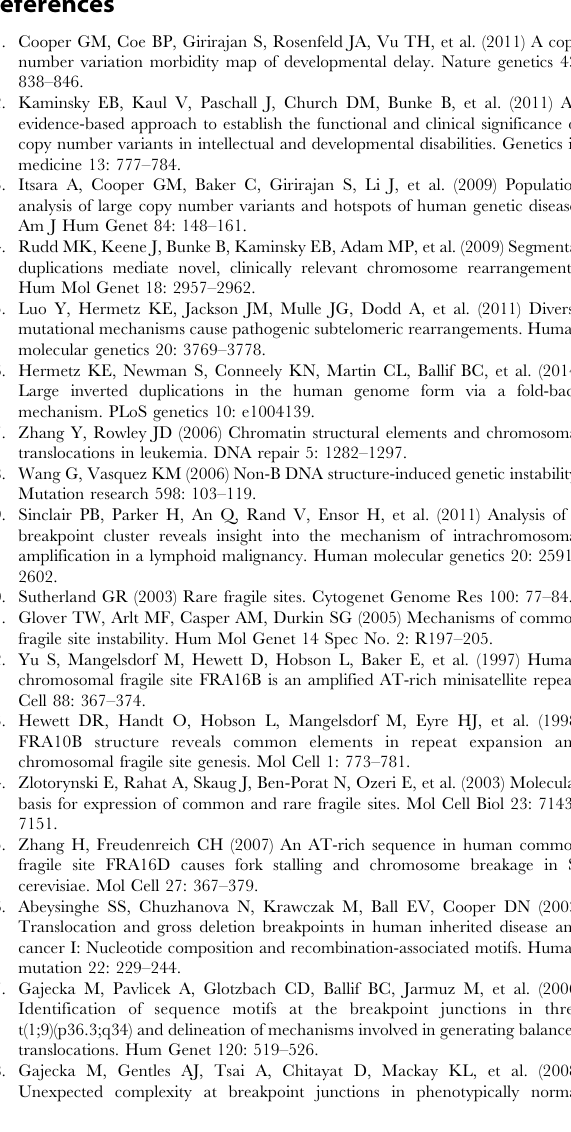
ment is described. Insertion length is listed for three sequenced junctions with insertions. Table S2 Distance from breakpoint region to the nearest chromosome end. Table S3 50-bp NestedMica (NM) motifs in the CNV breakpoint region dataset (B) and control datasets (C1- C20). The number of sequences with at least one NM motif and the number of NM motifs per dataset are listed. Table S4 Tandem repeats (TR) in the CNV breakpoint region dataset (B) and control datasets (C1-C20). The number of sequences with at least one TR and the number of TRs per dataset are listed. Table S5 G-quadruplex consensus sequences (G 3 + N 1–7 G